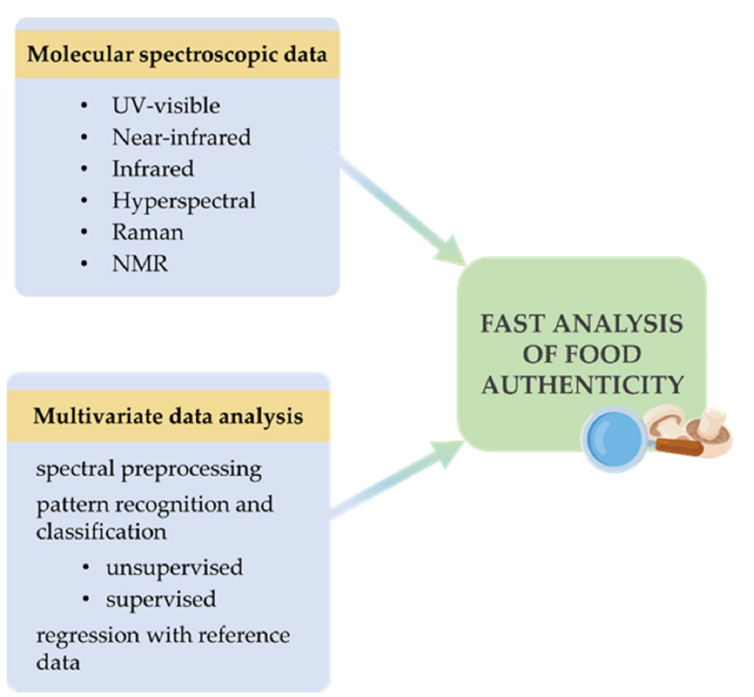
Figure 4. Molecular spectroscopy methods and chemometric data evaluation in food